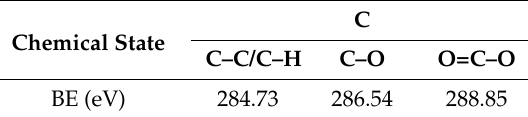
Table 3. Fitting results for each binding energy